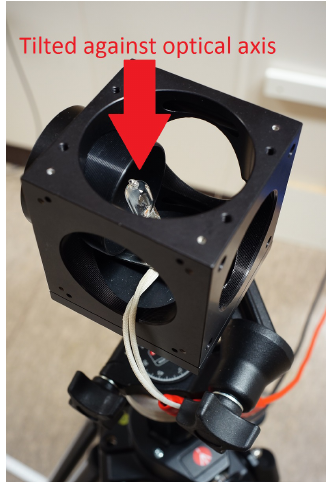
Figure 1. Setup of the lamp system. The bulb is tilted against the optical axis to avoid channeling. The lamp system is mounted on a height-adjustable tripod for the fine adjustment of the light